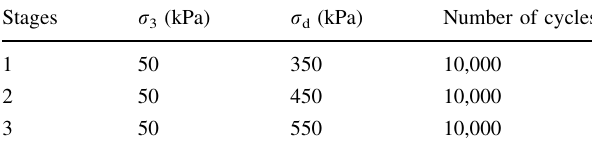
Table 5 Stress sequences for PD test